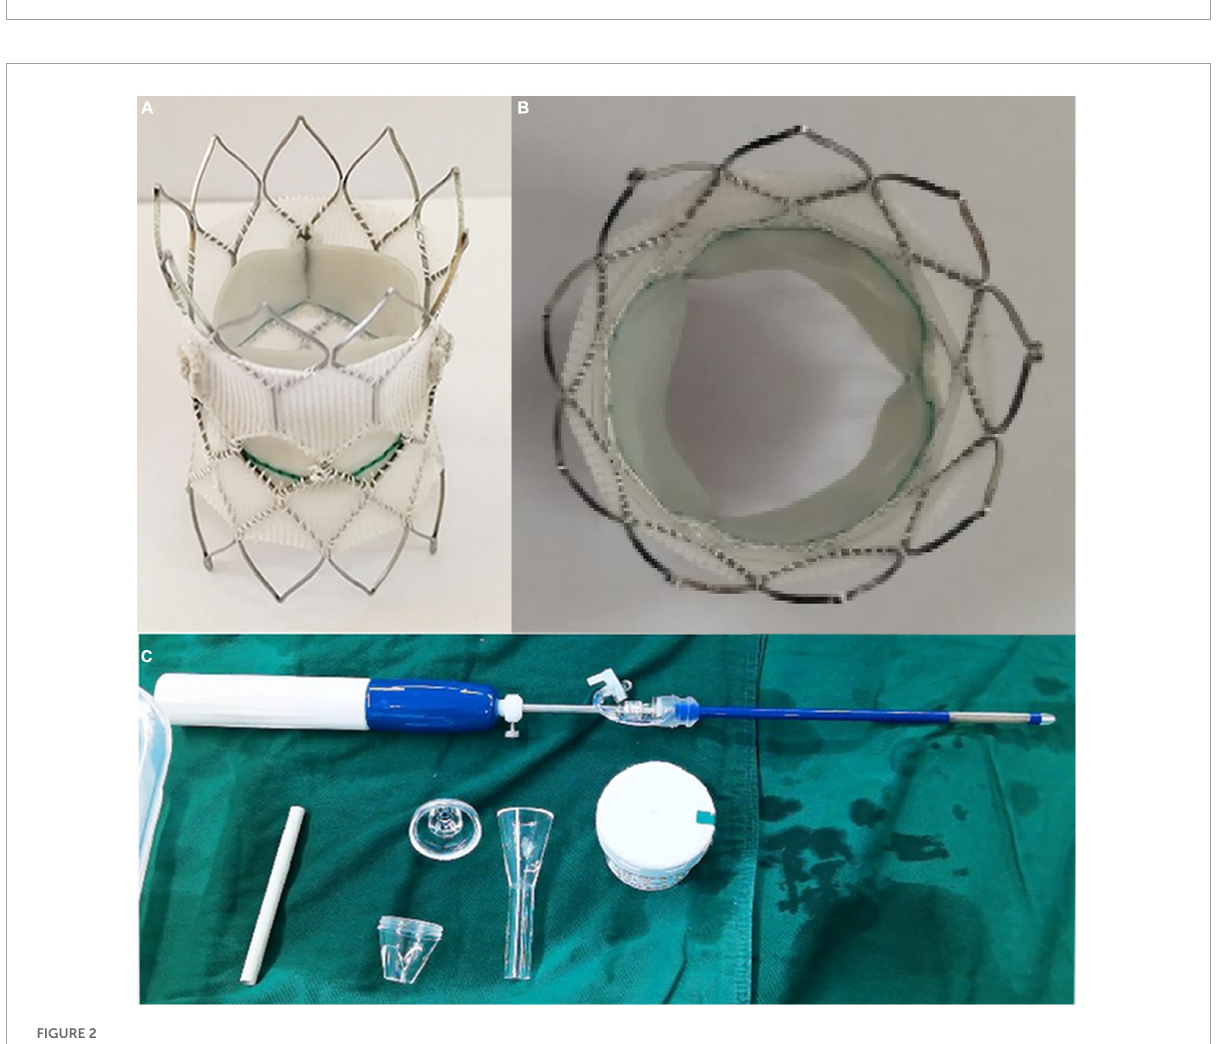
FIGURE2 Salus valve (A,B) and delivery system (C)